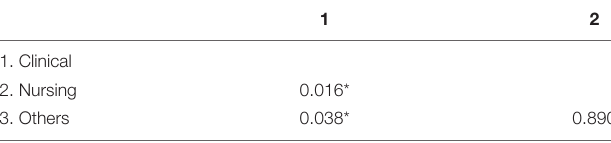
TABLE 8 | Multiple comparative analysis of different medical specialty.